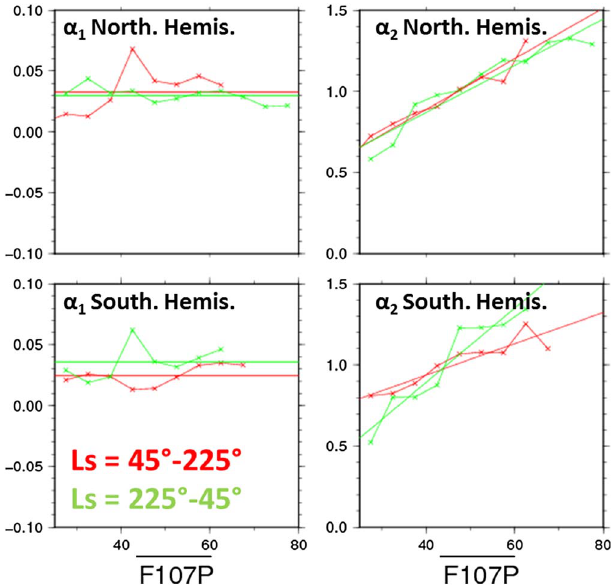
Fig. 3. Coef fi cients a 1 and a 2 estimated from the least-square adjustment of equation (3). Top: for the Northern hemisphere; Bottom: for the Southern hemisphere. The colours are related to the Martian seasons with 45 (cid:3) (cid:5) Ls < 225 (cid:3) for the red curve and 225 (cid:3) (cid:5) Ls < 45 (cid:3) for the green curve. The lines are the estimated a 1 and a 2 coef fi cients with respect to the F 10 : 7 P . The crosses are the coef fi cients obtained for the different F 10 : 7 P index while the lines are the values used in the model.